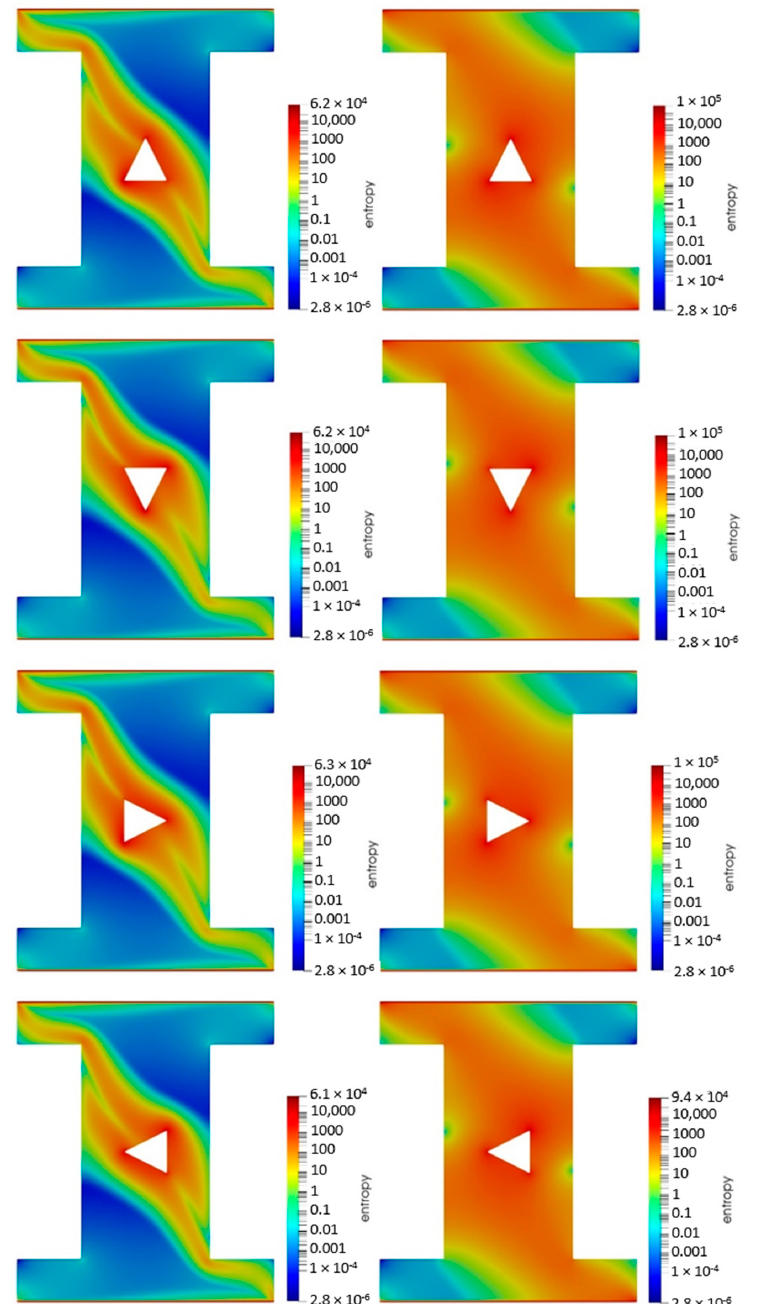
Figure 7. Entropy generation of the 4% vol. NF in two different cavities including the sand-based ( left column ) and the metallic powder-based ( right column ) porous cavities with different orientations of the hot block.